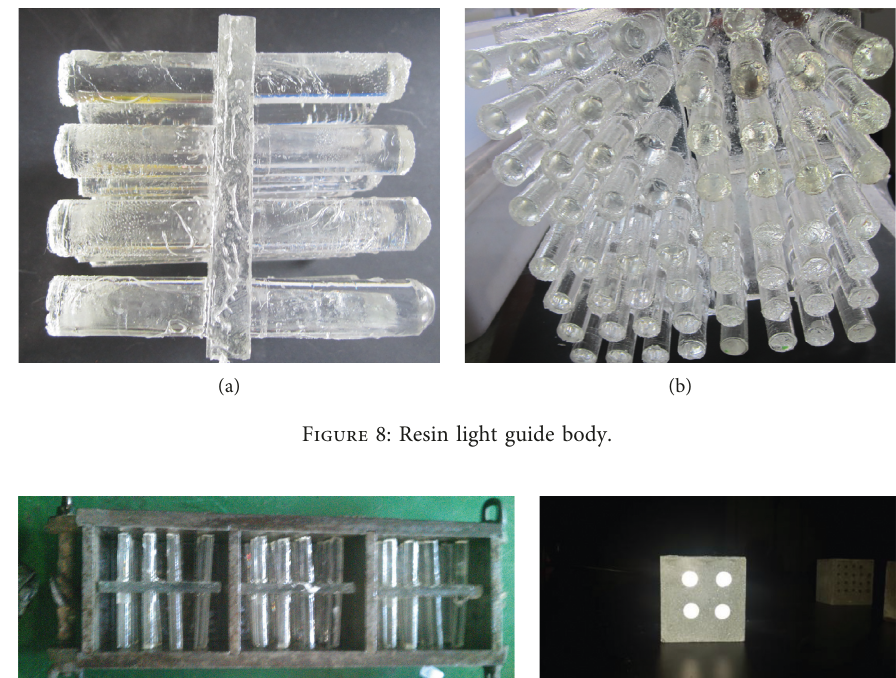
Figure 9: Fabrication of RTMC block. (a) Pouring mould. (b) Resin translucent concrete